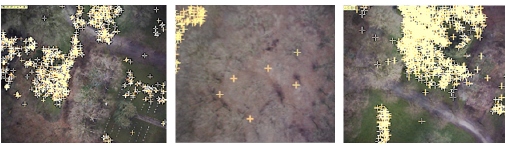
Figure 5: Examples for automatic tie points (crosses) on forest